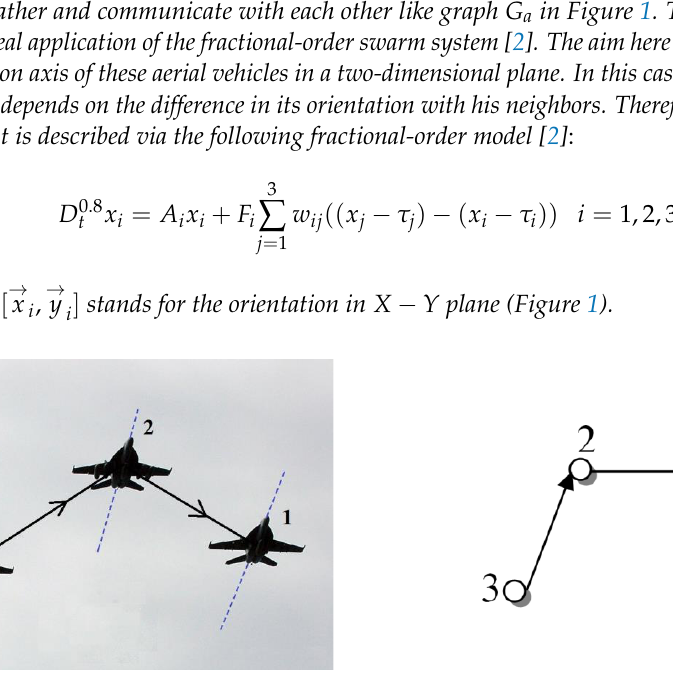
Figure 1. Triangular formation of aerial vehicles and graph G a , which indicates the communications among these agents [2].